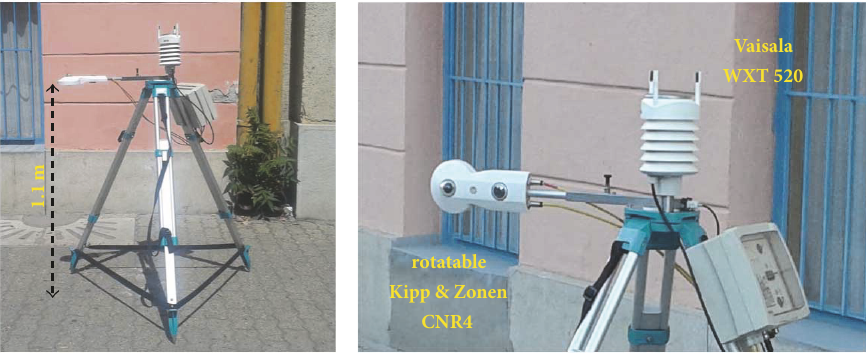
Figure 3: One of the human-biometeorological stations used in this study (photo taken at P3 site).